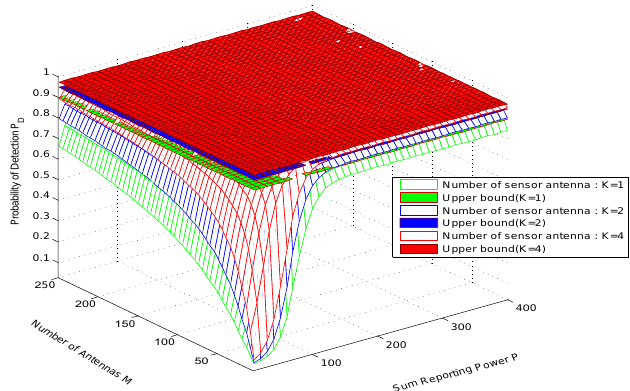
Figure 4. P D vs. M and P , when sensor antenna number K = 1, 2, 4.